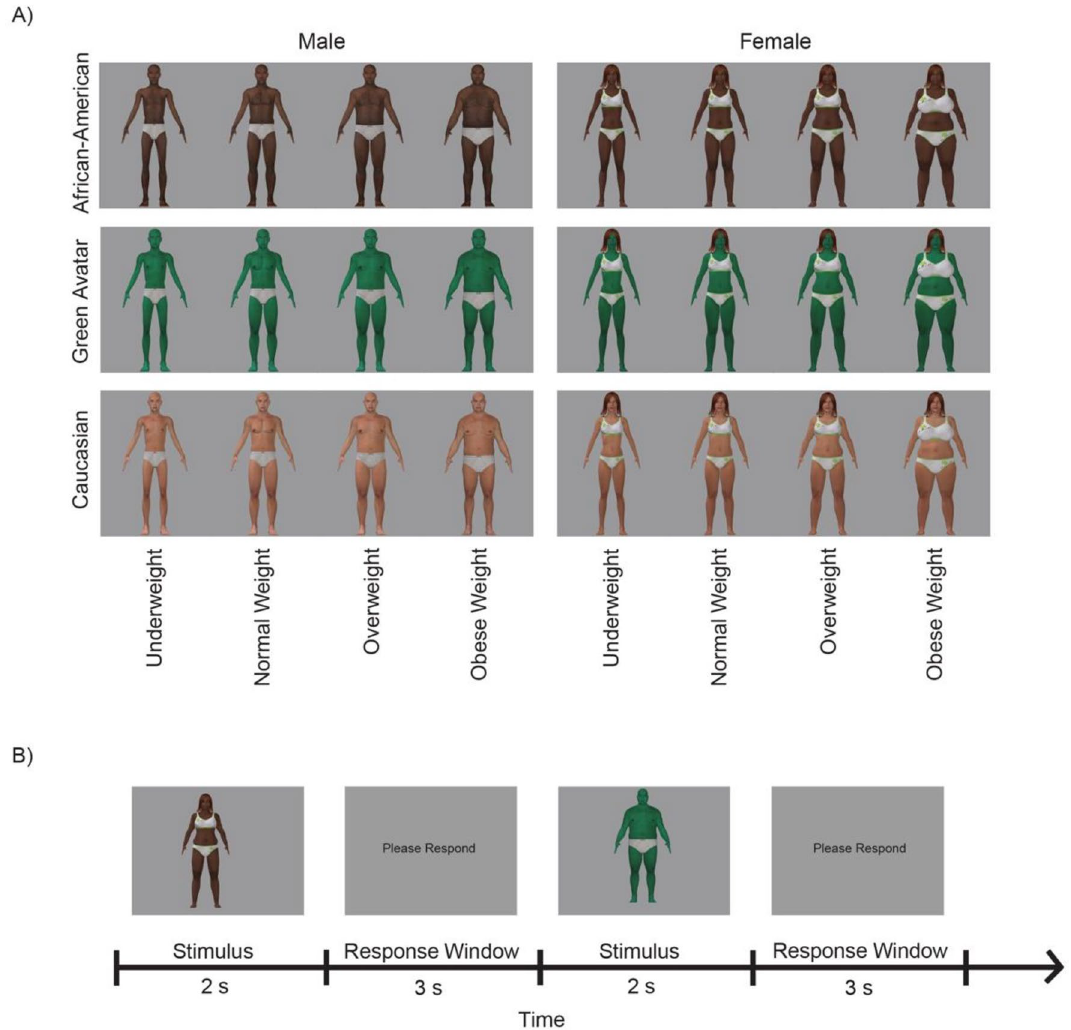
Figure 4. Experimental paradigm for the visual categorization task. ( A ) Example stimuli set, a condition-rich paradigm consisting of a total of 24 conditions through a 2 × 3 × 4 within-subject factorial design, comprised of 2 gender types (male, female), 3 race types (African–American, Caucasian, Green Avatar as a control type), and 4 types of BMI weight categories (underweight, normal, overweight, obese) of the body stimuli. Each condition consisted of 5 computer-generated individual identities. ( B ) Example trial, where each body stimulus was presented for 2 s, followed by a 3-s response window. Participants were asked to judge whether each stimulus was underweight, normal, overweight, or obese by pressing the corresponding button on the